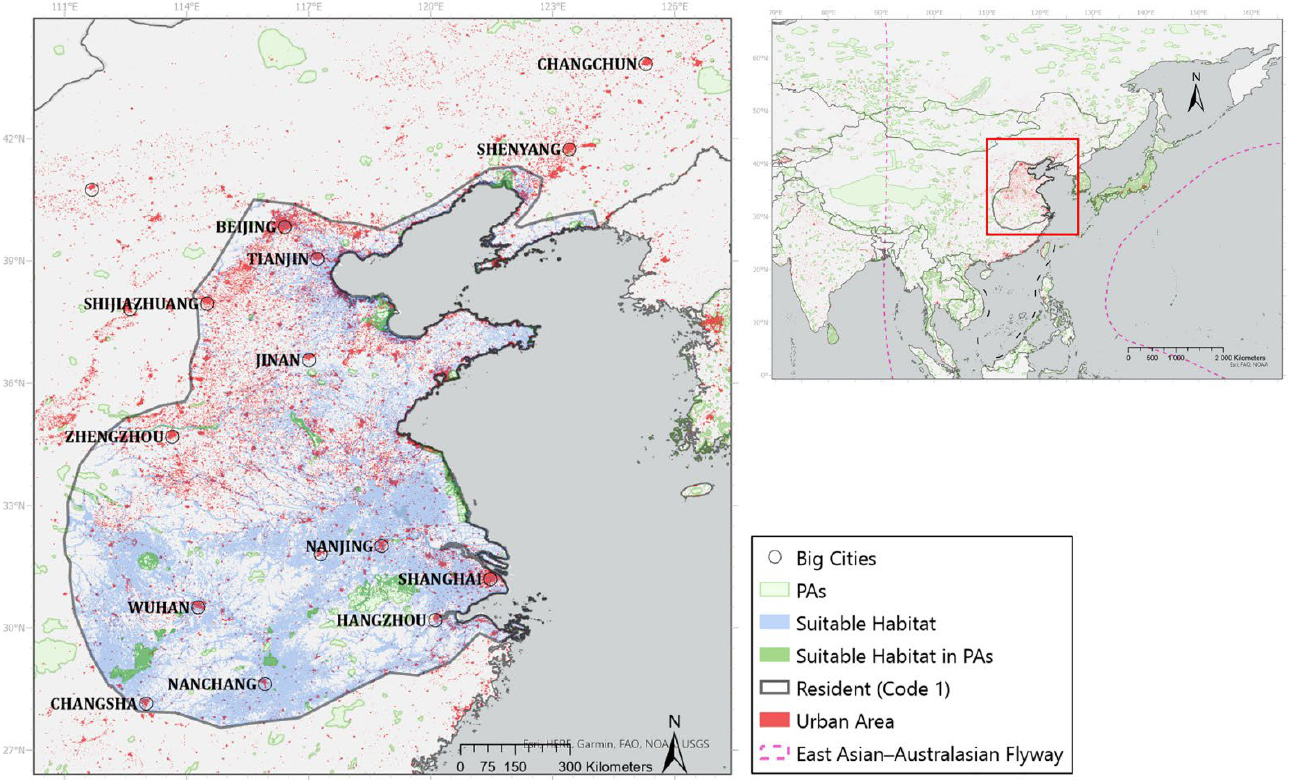
Figure 7. The most important habitat of BP has overlap with large cities.